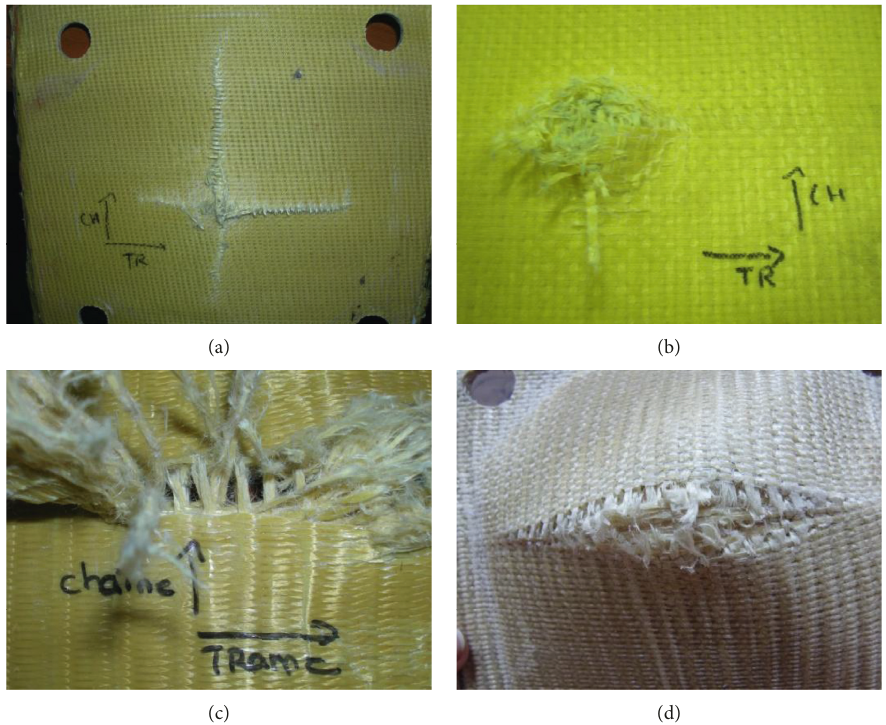
Figure 15: Different failure types of 3D interlock fabrics submitted to FSP impact. (a) Bidirectional failure type. (b) Localized failure type. (c) Unidirectional failure type without yarn rupture. (d) Unidirectional failure type with yarn rupture.